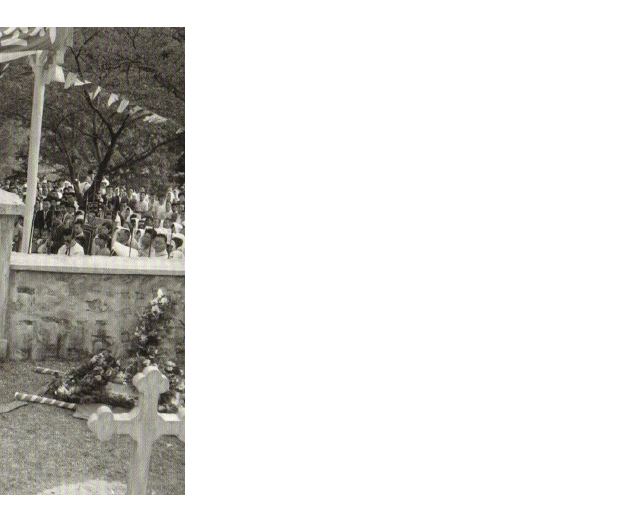
Figure 13. Image dated 1928 [source: The Dong-A Ilbo , 5 October 1928].